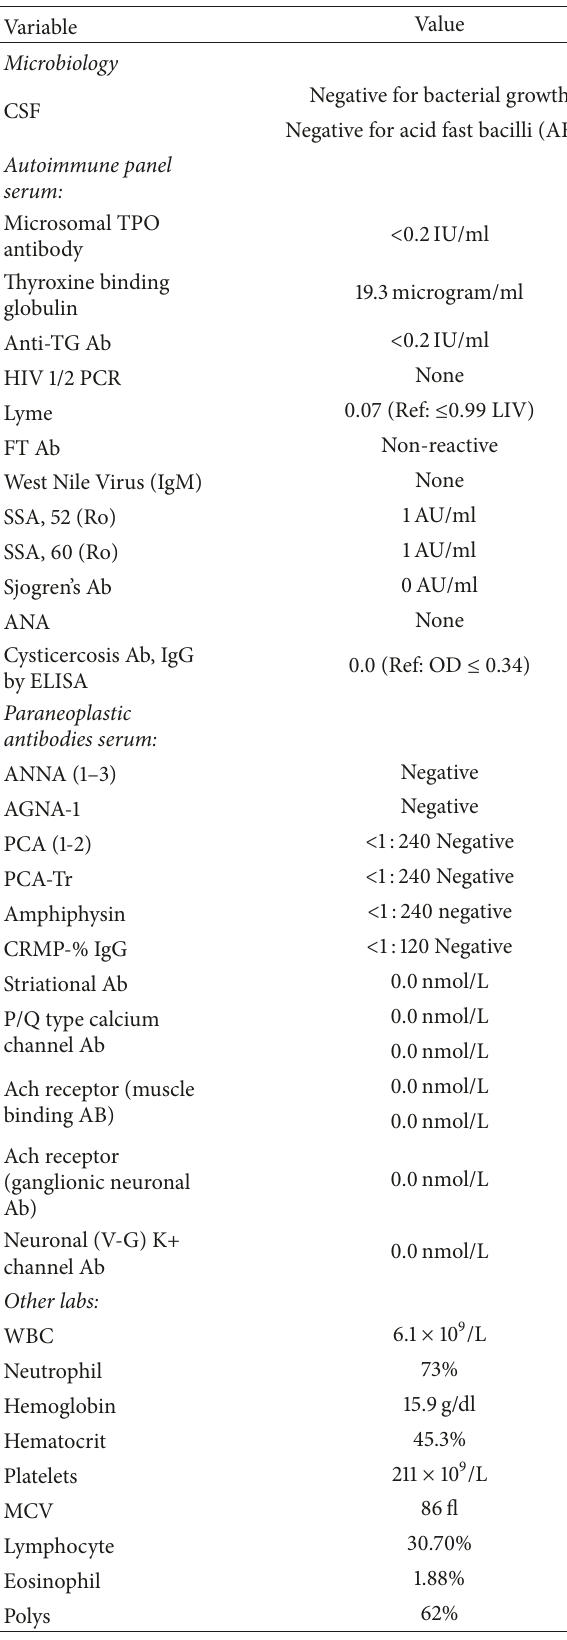
Table 1: Laboratory